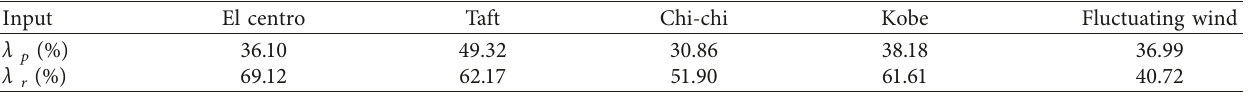
Table 1: λ p and λ r of original structure under earthquake and fluctuating